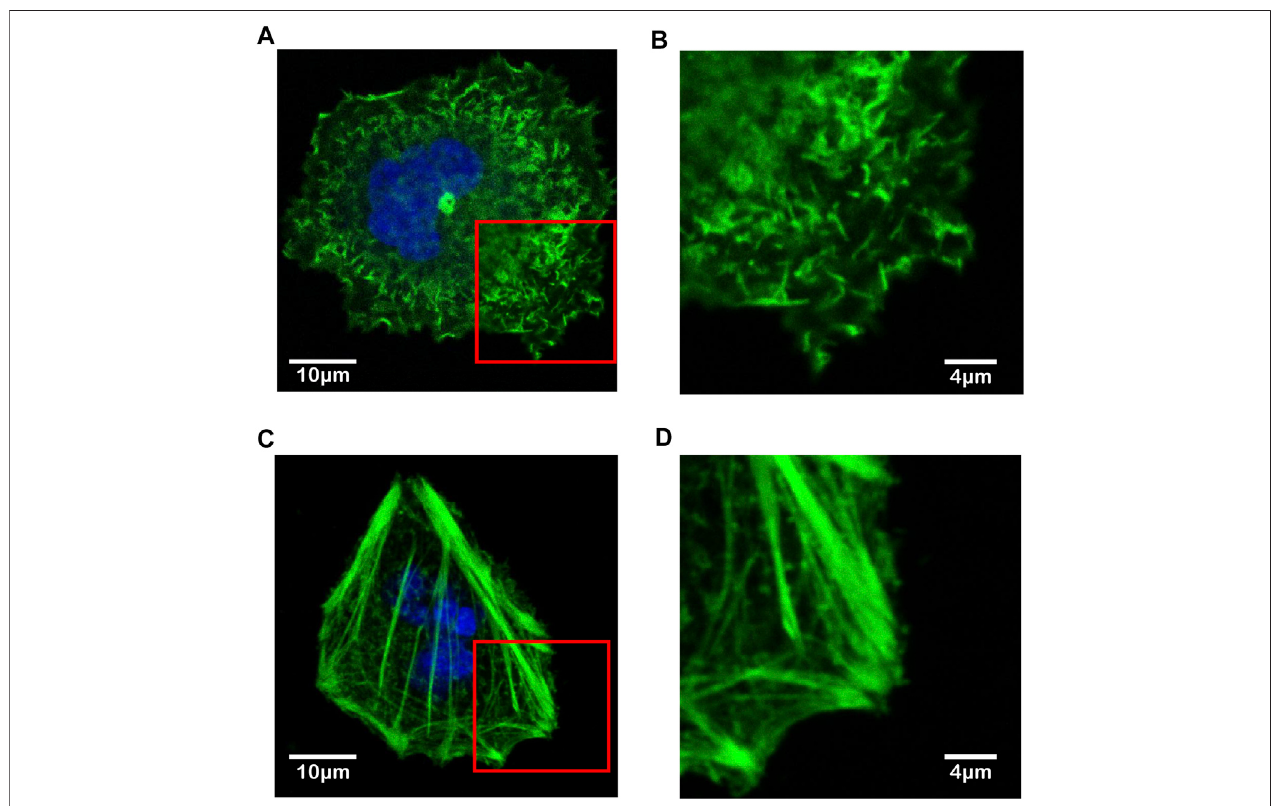
FIGURE6| Immuno fl uorescenceconfocalmicroscopyimagesofF-actin fi lamentsinlivingHuh-7cellsunderdifferentpHmicroenvironments. (A,B) F-actininHuh- 7 cell at pH 7.4. (C,D) F-actin in Huh-7 cell at pH 6.5. The F-actin fi laments are highlighted by green and the cell nuclei by blue. The view of (B) and (D) magni fi es the rectangular region near the periphery of cell within the red box in (A) and (C) ,